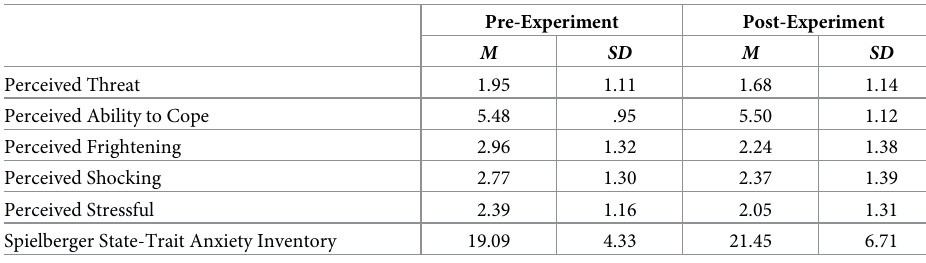
Table 2. Mean self-report